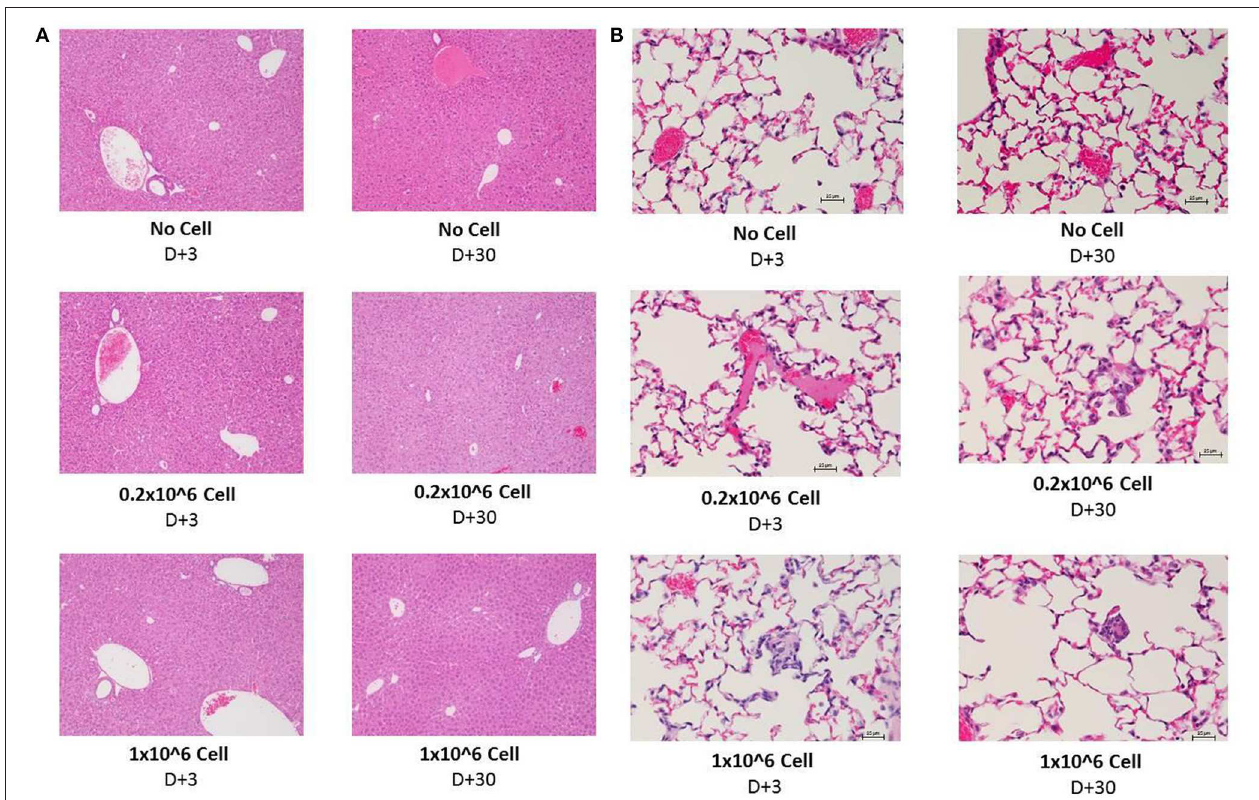
FIGURE 6 | Histopathology evaluation of lung and liver after i.v. infusion of human DSCs in healthy mice. To assess the effect of cell infusion on vital organs liver, lung and kidney were prepared for histopathology evaluation 3 and 30 days after different doses of cell infusion ( N = 3 mouse per dose/timepoint). (A) Liver tissue with no cell, 0, 2, and 1 × 10 6 DSC IV injection ( + heparin) 3 days (left column) and 30 days after cell infusion. (B) Lung tissue with no cell, 0, 2, and 1 × 10 6 DSC IV injection ( + heparin) 3 days (left column) and 30 days after cell